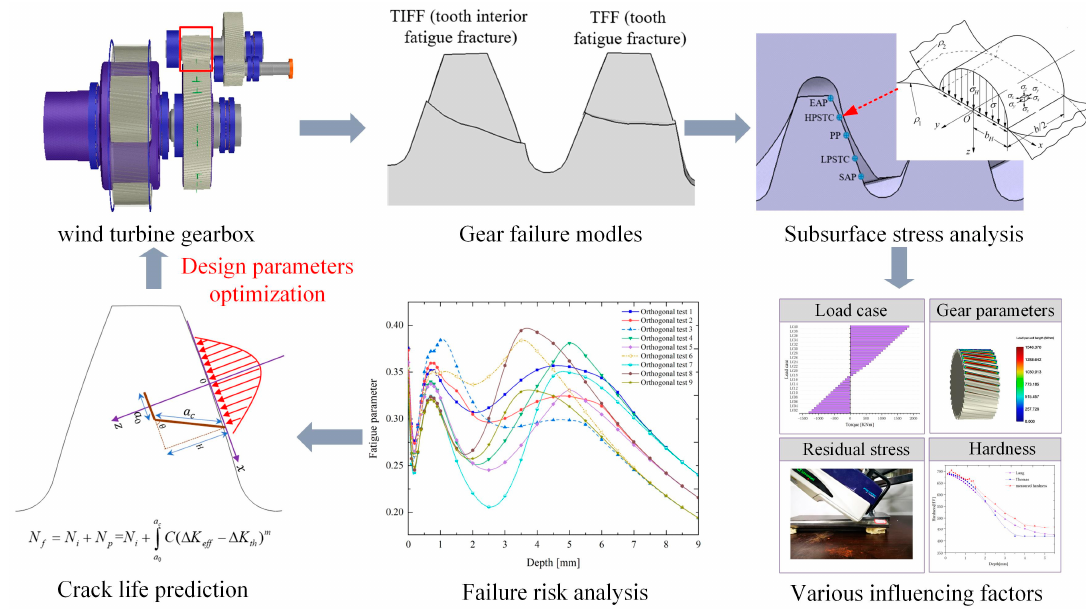
Figure 3. The technical route of the model. Table 1. Gear parameters.